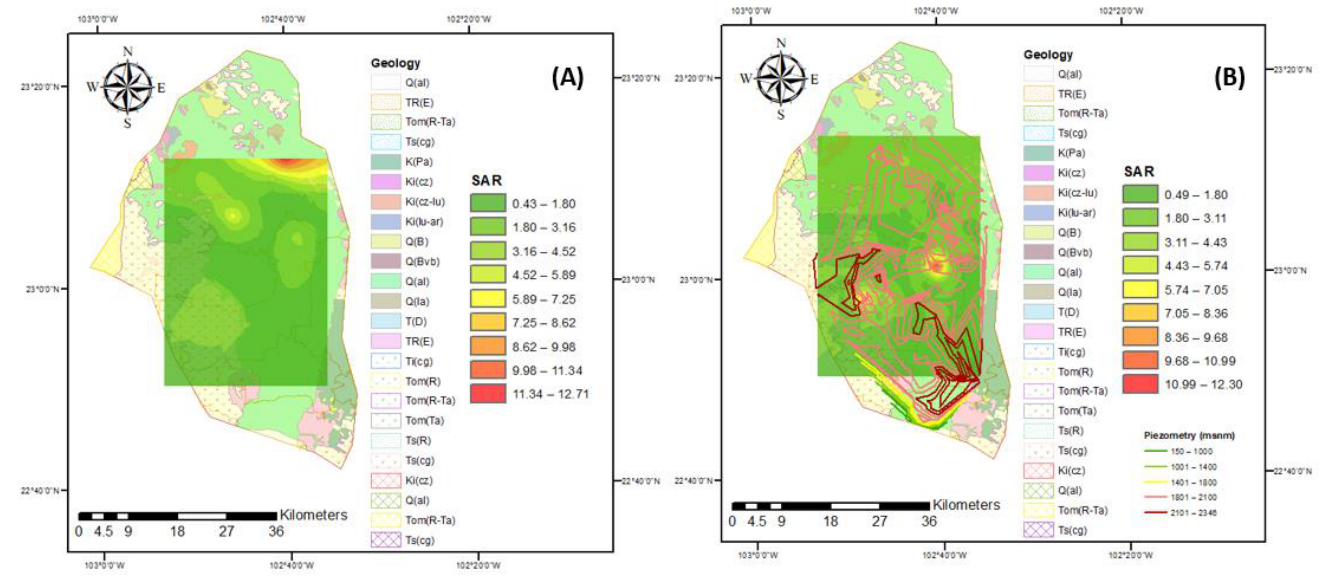
Figure 8. SAR for the years ( A ) 2005 and ( B ) 2015.